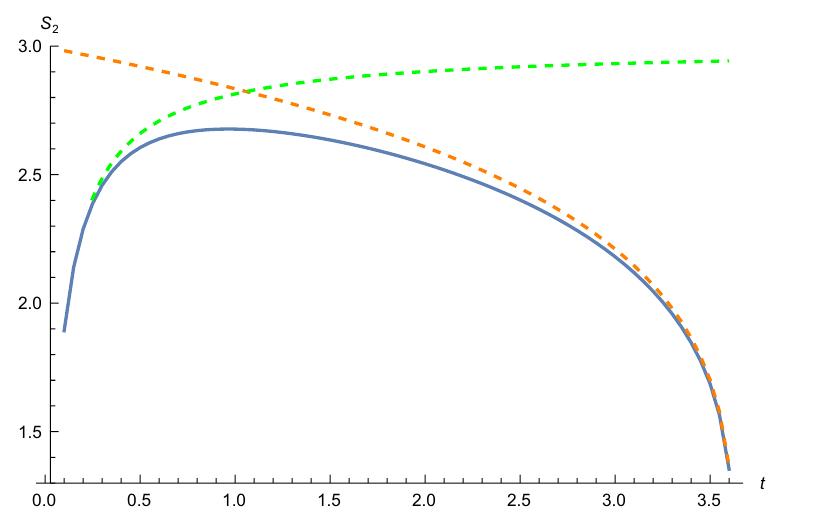
Figure 4 . Plot of the second Rényi entropy S 2 in (4.3) as a function of t = g s K . We set ξ = 18 , β = 4 , g s = 1 / 100 in this figure. The solid blue curve is S 2 in (4.3). The dashed orange curve represents e S 2 in (4.2) while the green dashed curve is S 2 without taking account of the back-reaction.